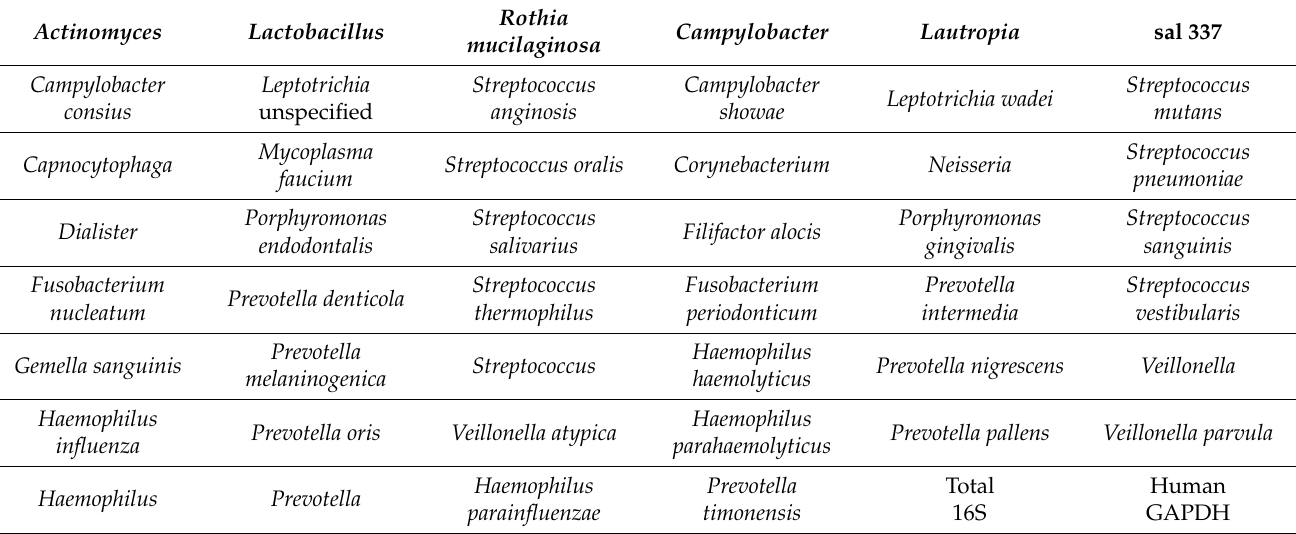
Table 2. Esophageal microbiome array (EMB) qPCR